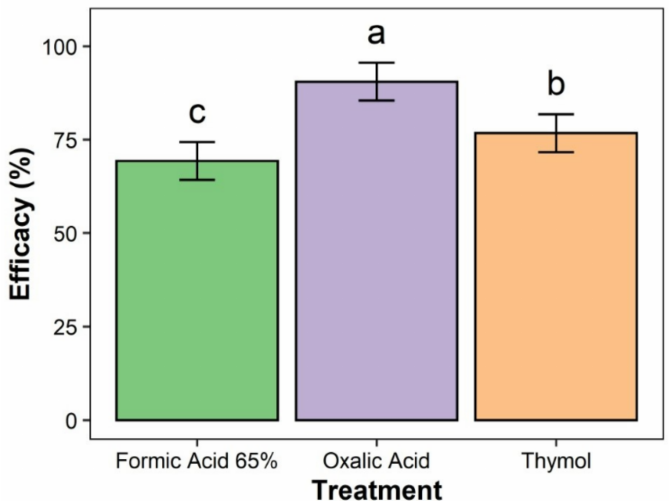
Figure 1. Efficacy of different treatment groups. Bars with the same letters are not significantly different ( p > 0.05); the error bars represent the confidence interval (95%).